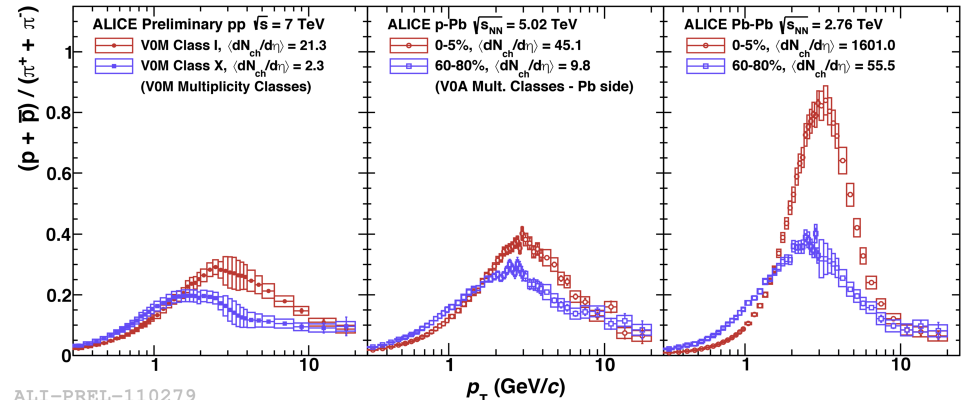
Figure 9. Proton to pion ratio in PbPb collisions as a function of p T at two centrality classes.